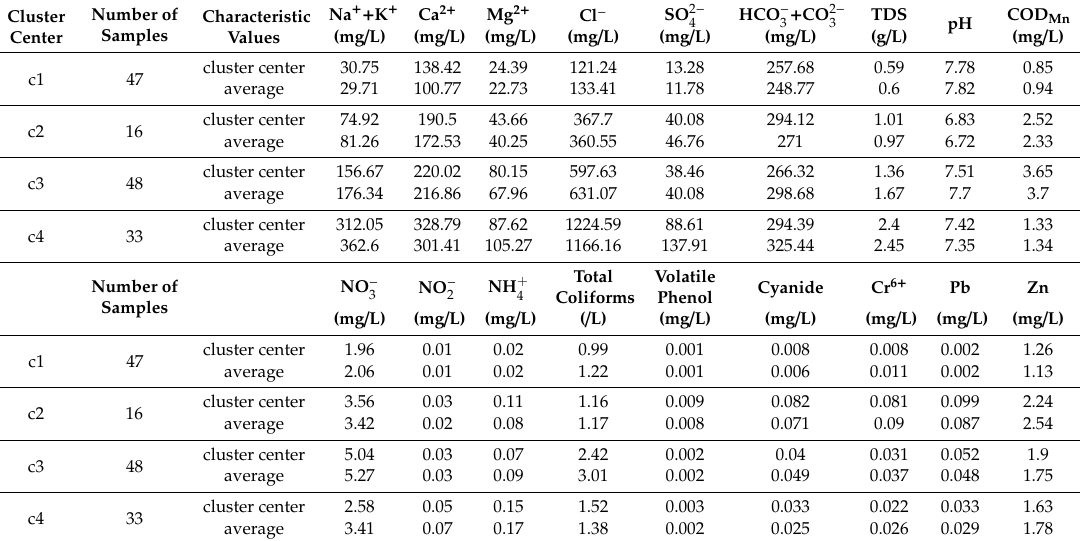
Table 5. Cluster centers and average concentrations of the groundwater quality indicators in each cluster. Number of Cluster Samples Center